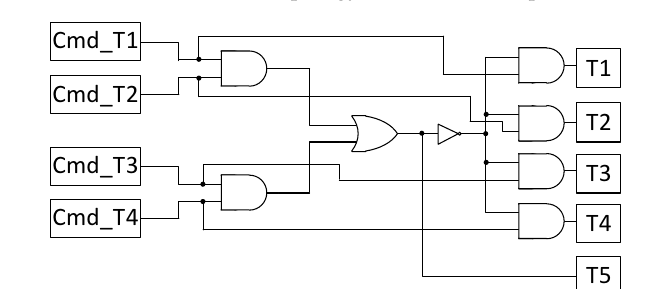
Figure 6. CSI5 topology with active clamp.